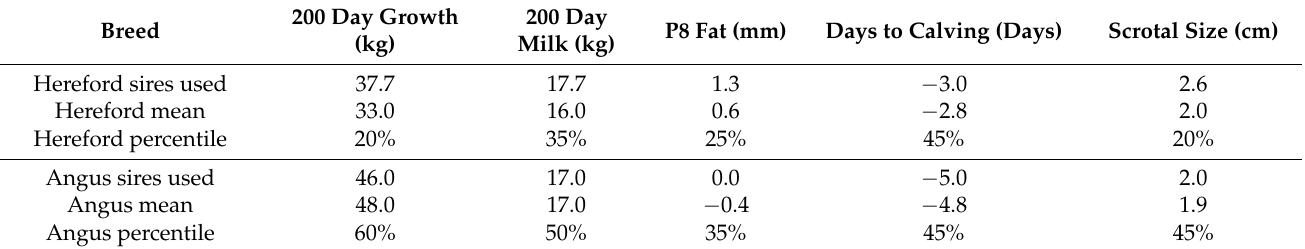
Table 2. BREEDPLAN EBVs for bulls used relative to breed